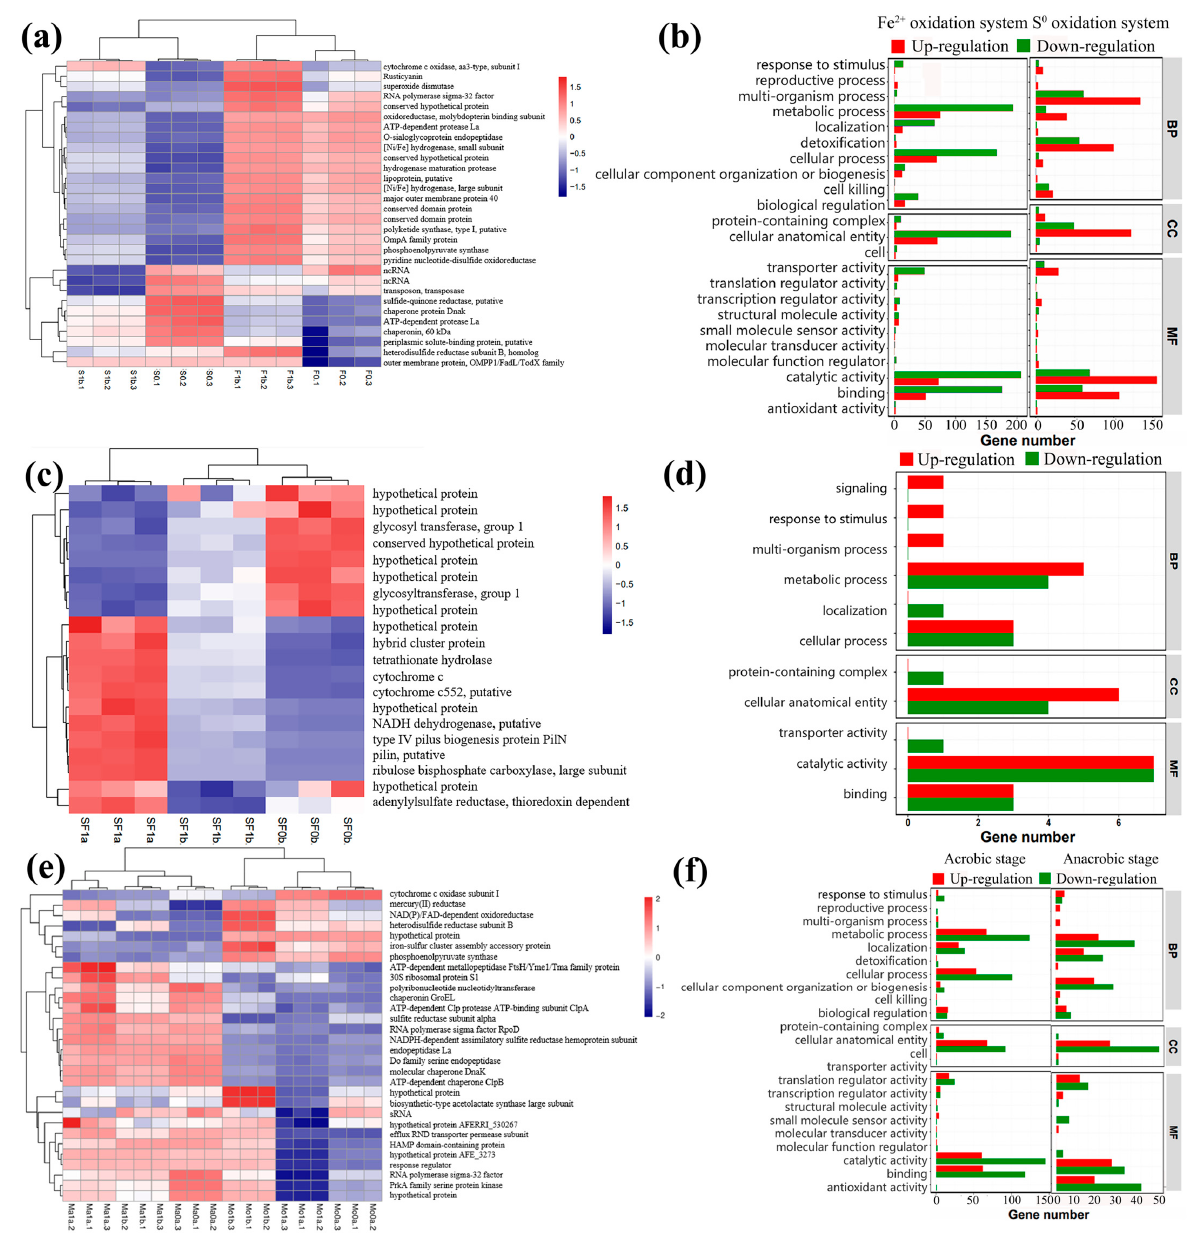
Figure 9. Heatmap of expression and GO analysis of DEGs by A. ferrooxidans ATCC 23270 in the presence of Hg 2+ . ( a ) Heatmap of expression during the oxidation of S 0 /Fe 2+ by A. ferrooxidans ATCC 23270 in the presence of Hg 2+ . ( b ) GO analysis of DEGs during the oxidation of S 0 /Fe 2+ by A. ferrooxidans ATCC 23270 in the presence of Hg 2+ (left: Fe 2+ oxidation system 1 mg/L [Hg 2+ ] vs. 0 mg/L [Hg 2+ ]; right: S 0 oxidation system 1 mg/L [Hg 2+ ] vs. 0 mg/L [Hg 2+ ]). ( c ) Heatmap of expression during the anaerobic Fe 3+ reduction coupled with S 0 oxidation of A. ferrooxidans ATCC 23270 in the presence of Hg 2+ . ( d ) GO analysis of DEGs during the anaerobic Fe 3+ reduction coupled with S 0 oxidation of A. ferrooxidans ATCC 23270 in the presence of Hg 2+ (1 mg/L [Hg 2+ ] at the last stage vs. 0 mg/L [Hg 2+ ]). ( e ) Heatmap of expression during the A. ferrooxidans ATCC 23270–pyrite interaction in the presence of Hg 2+ . ( f ) GO analysis of DEGs during A. ferrooxidans ATCC 23270–pyrite interaction in the presence of Hg 2+ (left: 1 mg/L [Hg 2+ ] at the last stage of the aerobic phase vs. 0 mg/L [Hg 2+ ] at the aerobic phase; right: 1 mg/L [Hg 2+ ] at the last stage of anaerobic phase vs. 0 mg/L [Hg 2+ ] at the anaerobic